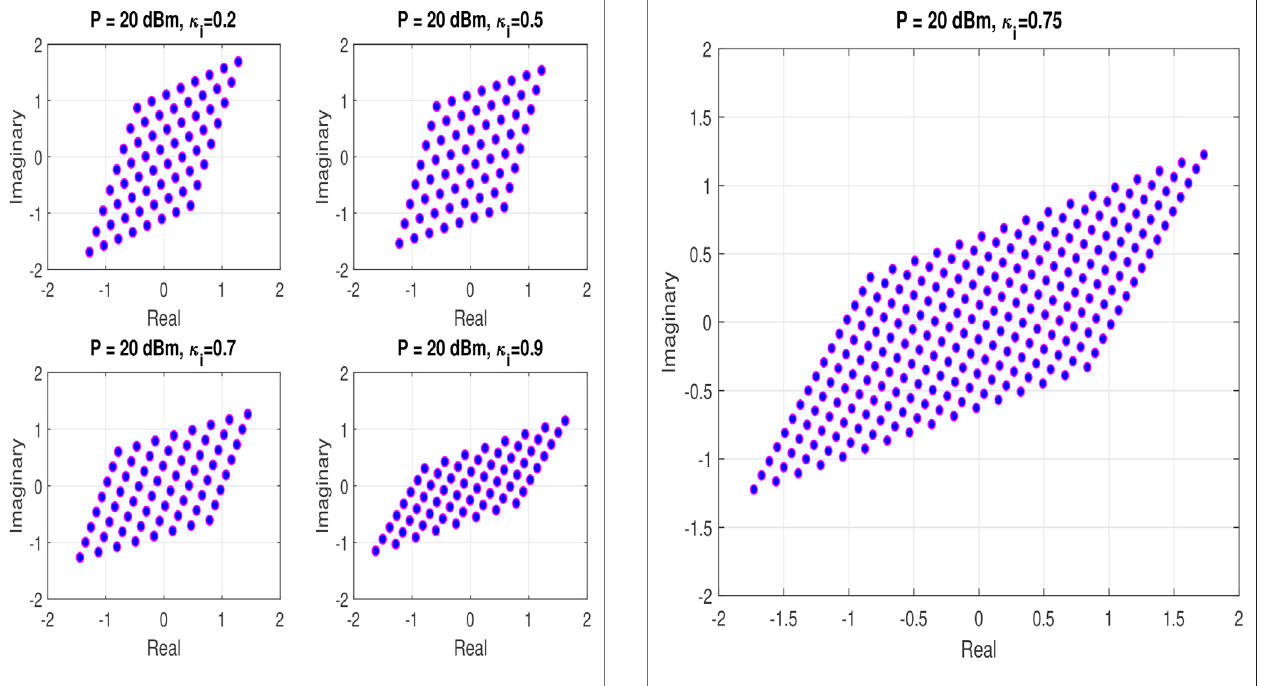
FIGURE 2 | Improper constellation diagram with 64-QAM. FIGURE 3 | Improper constellation diagram with